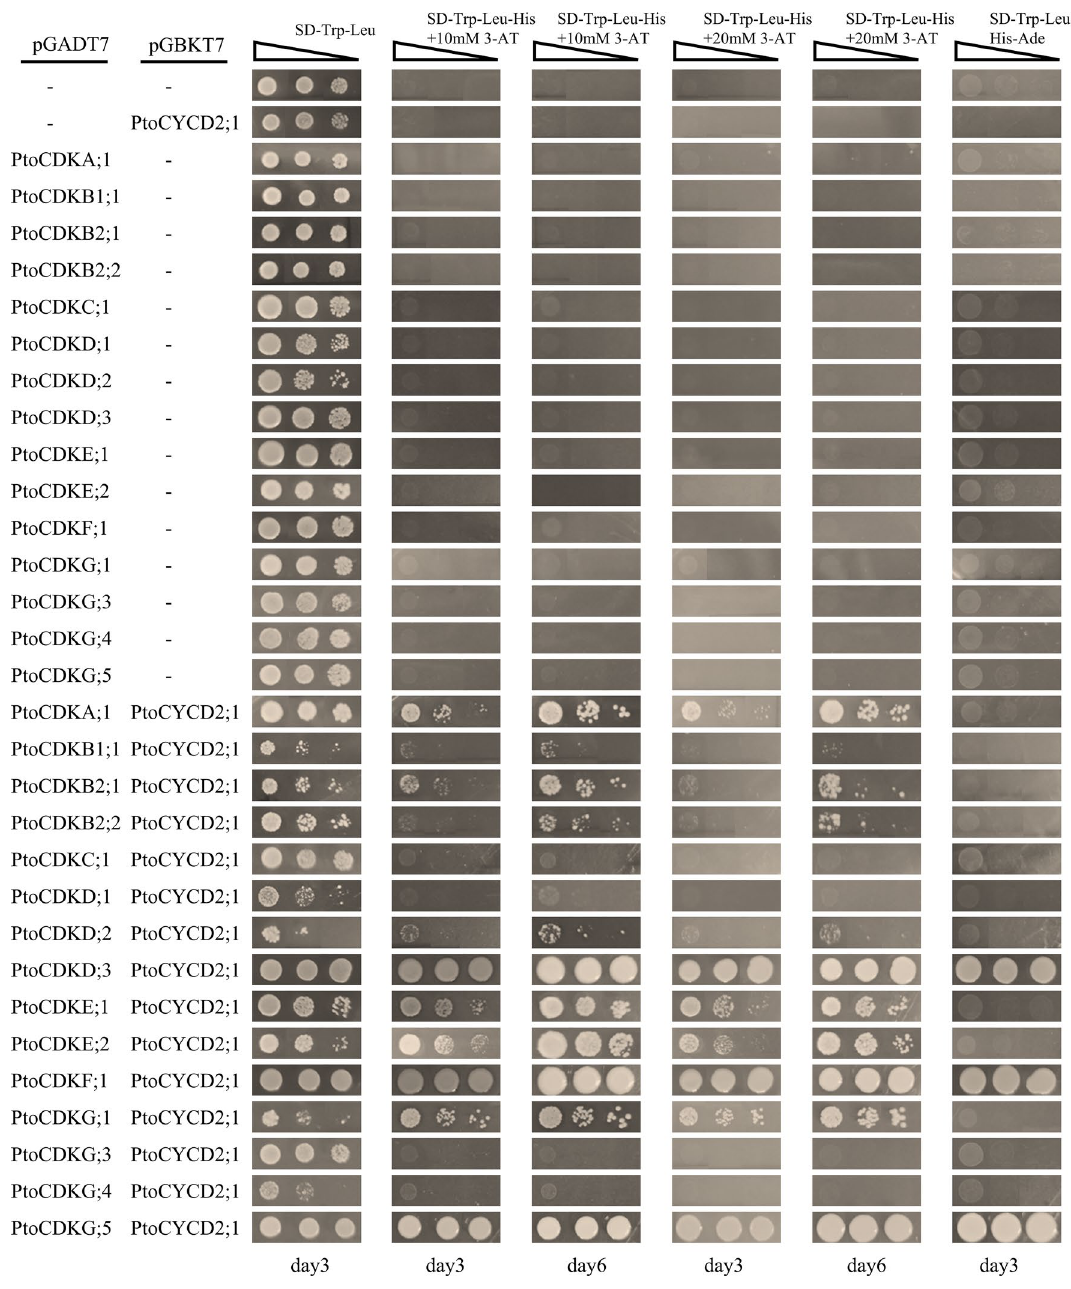
Figure 7. Protein–protein interactions of PtoCYCD2;1 with PtoCDKs. Yeast cells were co-transformed with pGBKT7 and pGADT7 constructs carrying the corresponding genes and grown on SD-Trp-Leu, SD-Leu-Trp- His + 10 mM 3-AT, SD-Leu-Trp-His + 20 mM 3-AT, SD-Leu-Trp-His-Ade. AD + BD, AD + BD-PtoCYCD2;1 and AD-PtoCDKs + BD, were used as negative control. Day represents the number of days of growth on the corresponding medium. The triangle represents dilution in a 0.1-fold gradient (1,0.1 and members in P. tomentosa , and this subclass has the largest number amongst woody plants of CDK subclasses, indicating that CDKG is irreplaceable in some functions. Tissue-specific expression results also show that alleles from different subgenomes are expressed, indicating that they are performing functions at the same time. The predictive analysis of cis-acting elements associated with hormone response and specific expression reveals that CYCD and CDK gene families are similar, suggesting their functional relatedness. The interaction between CYCDs and CDKs indicates that the interactions between different CYCD subclasses and CDKs are different. The interactions amongst D1, D2/4, D3, D5, D6, D7 and CDKs are significantly different (Fig. 5), indicating that the functional differences amongst different CYCD members are reflected in evolutionary relationships and sequence characteristics and may be related to the different interactions between them and CDKs. The cyclin interaction network study in Arabidopsis shows that the interaction relationship of different